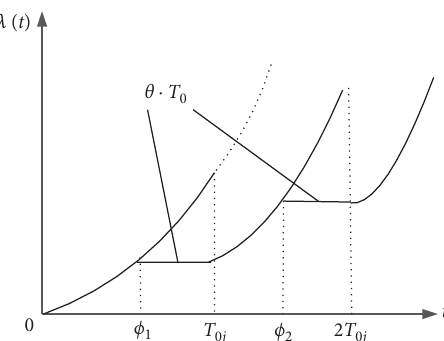
Figure 3: The change of product failure rate under imperfect